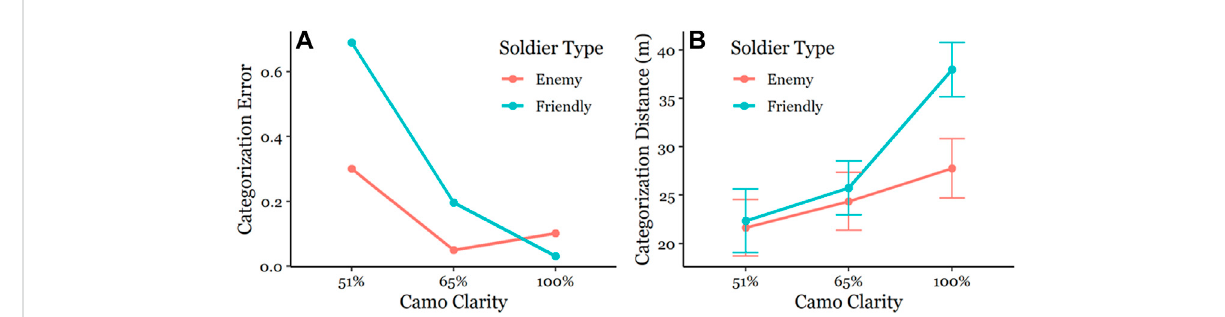
FIGURE 2 (A) Mean Categorization Error as a function of Camo Clarity and Soldier Type. Errors were signi fi cantly higher for Friendly Soldiers relative to Enemy Soldiers in the 51CC and 65CC conditions ( p < 0.001). Errors were signi fi cantly higher for Enemy Soldiers relative to Friendly Soldiers in the